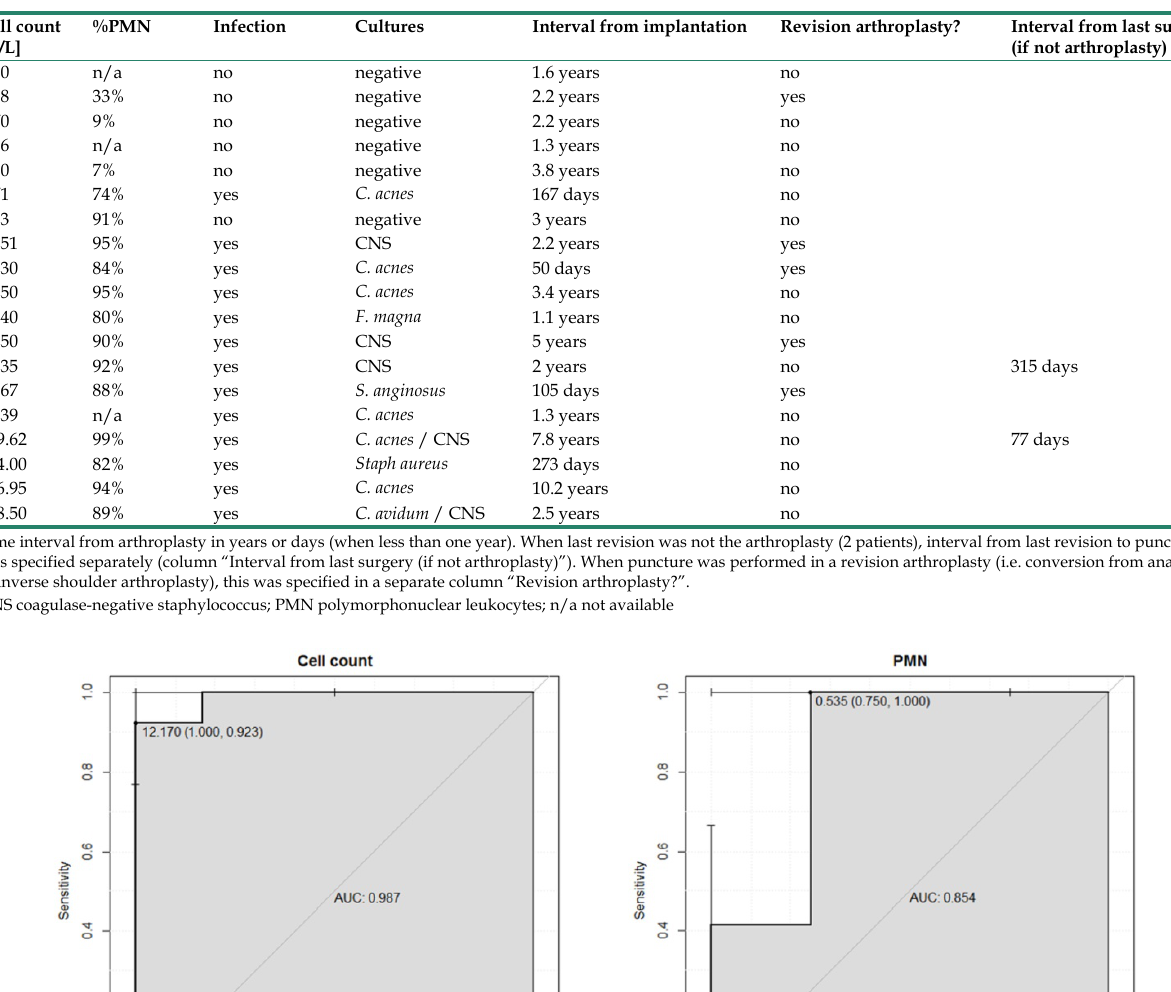
Table 1 . Cell counts and differential PMN, culture results of 19 aspirates.